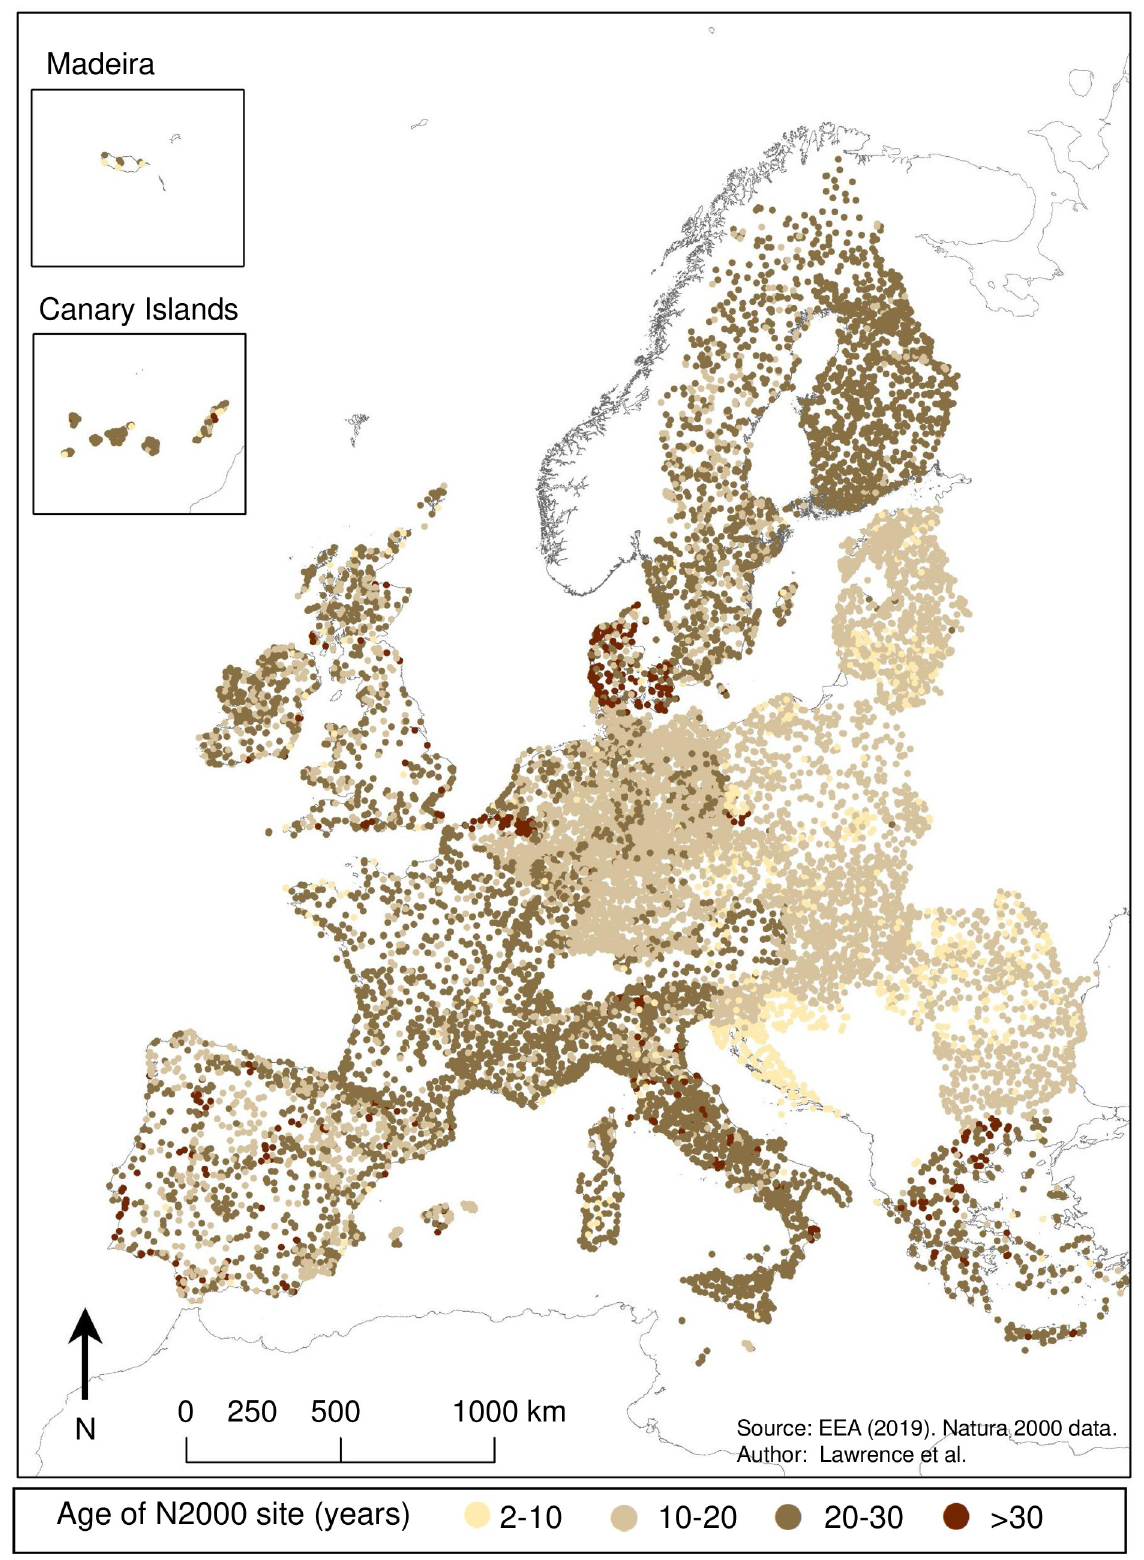
Fig 8. Age of N2k sites. Recently protected PAs within the N2k network are predominantly located in eastern European member states which joined the EU since 2004 (Status 2017) [55]. Map generated in ArcGIS 10.6.1 (http://www.esri.com/software/arcgis/arcgis-for-desktop). https://doi.org/10.1371/journal.pone.0258615.g008 PLOS ONE | https://doi.org/10.1371/journal.pone.0258615 October 21,